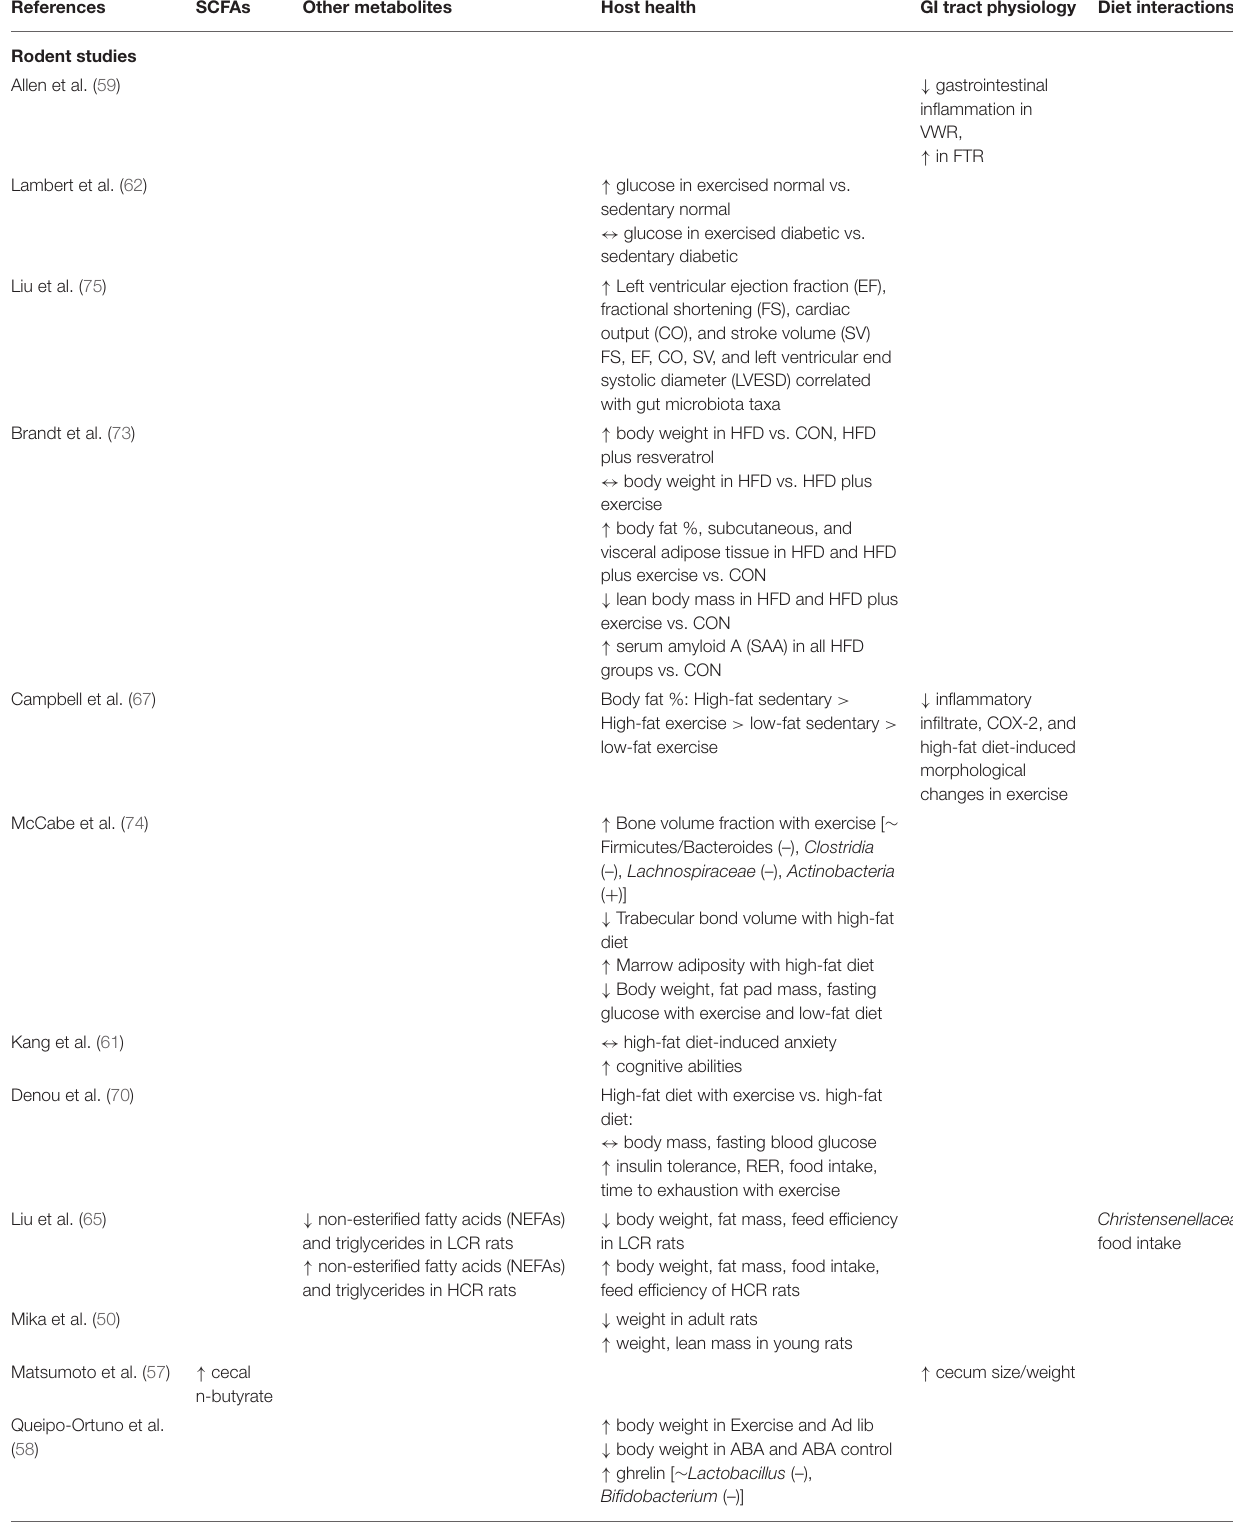
TABLE 2 | Summary of effect of exercise on the microbial metabolites, host health, and dietary